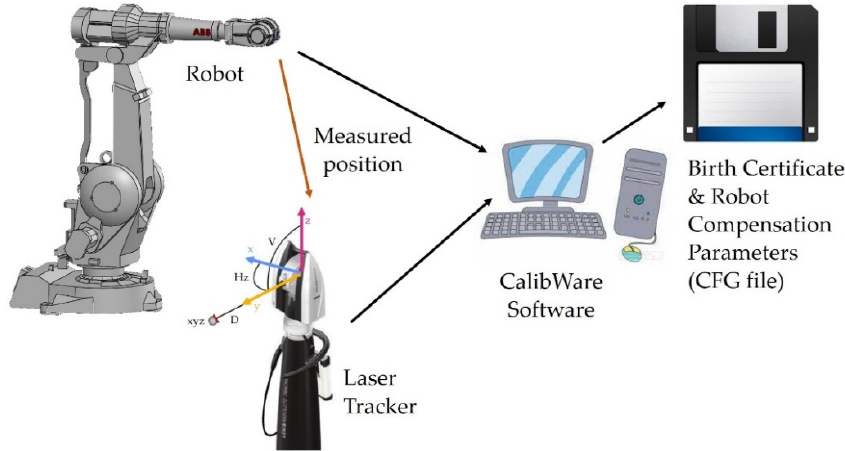
Figure 4. Configuration of the ABB calibration process.